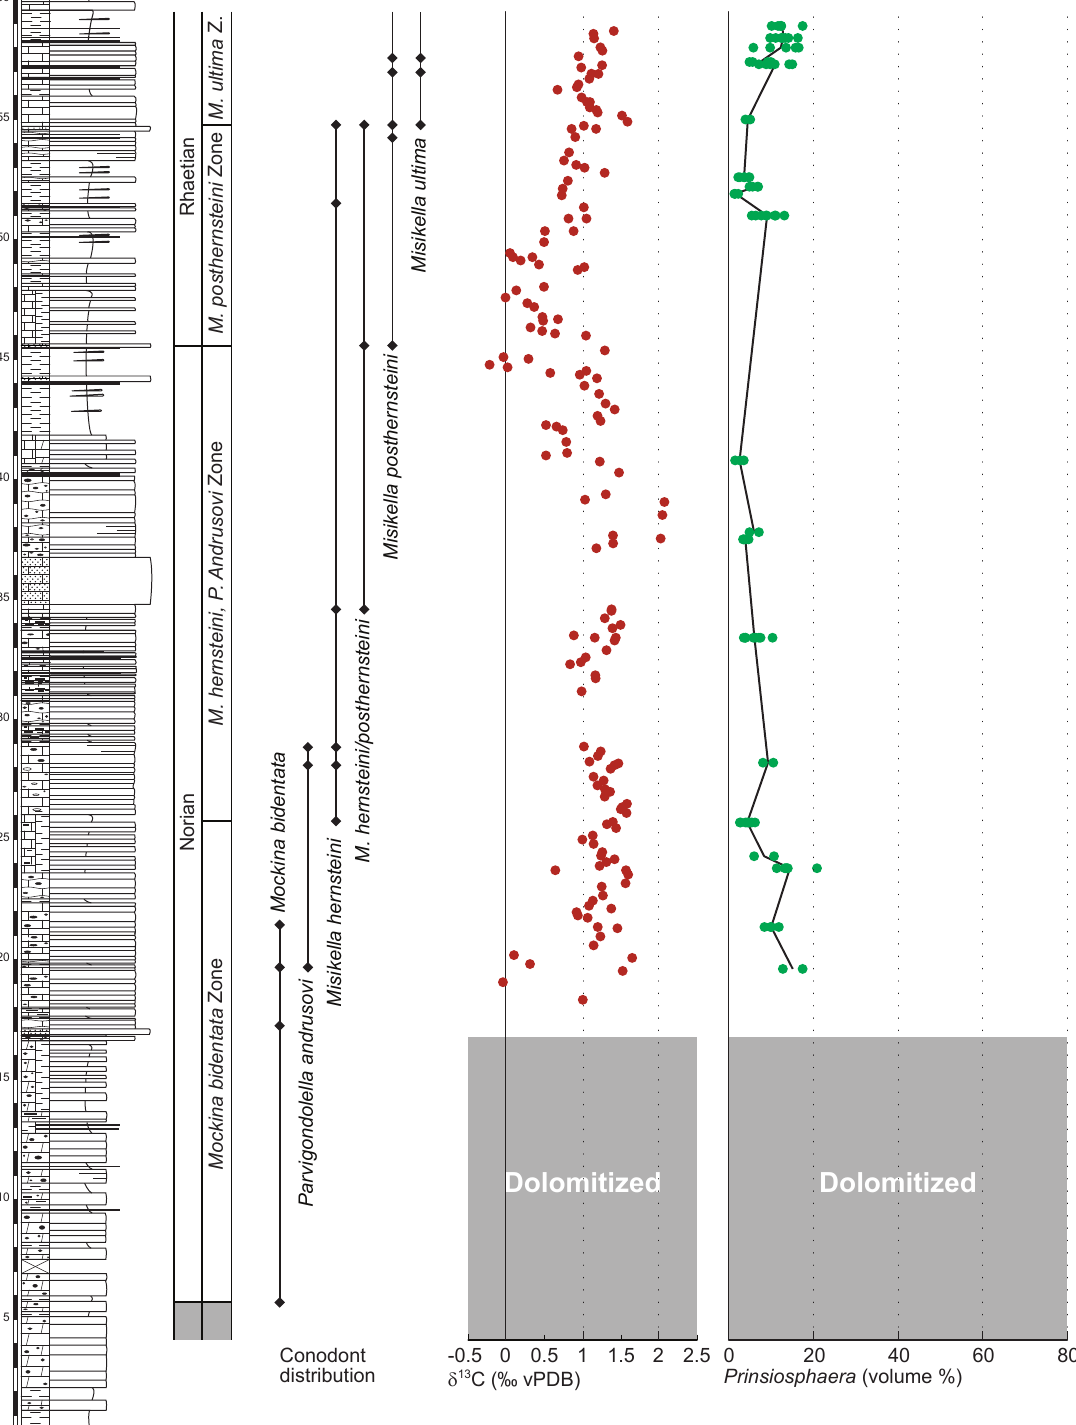
Fig. 3. Stratigraphy, stable carbon isotopes from bulk carbonate and volume proportion of calcareous nannofossils at Pignola-Abriola (Lagonegro Basin, southern Apennines, southern Italy). The black line connects mean volume proportions of nannofossils. Conodont dis- tribution and biozones from Giordano et al. (2010). Conodont biozones according to Kozur and Mock (1991). Lithological symbols as in Fig.